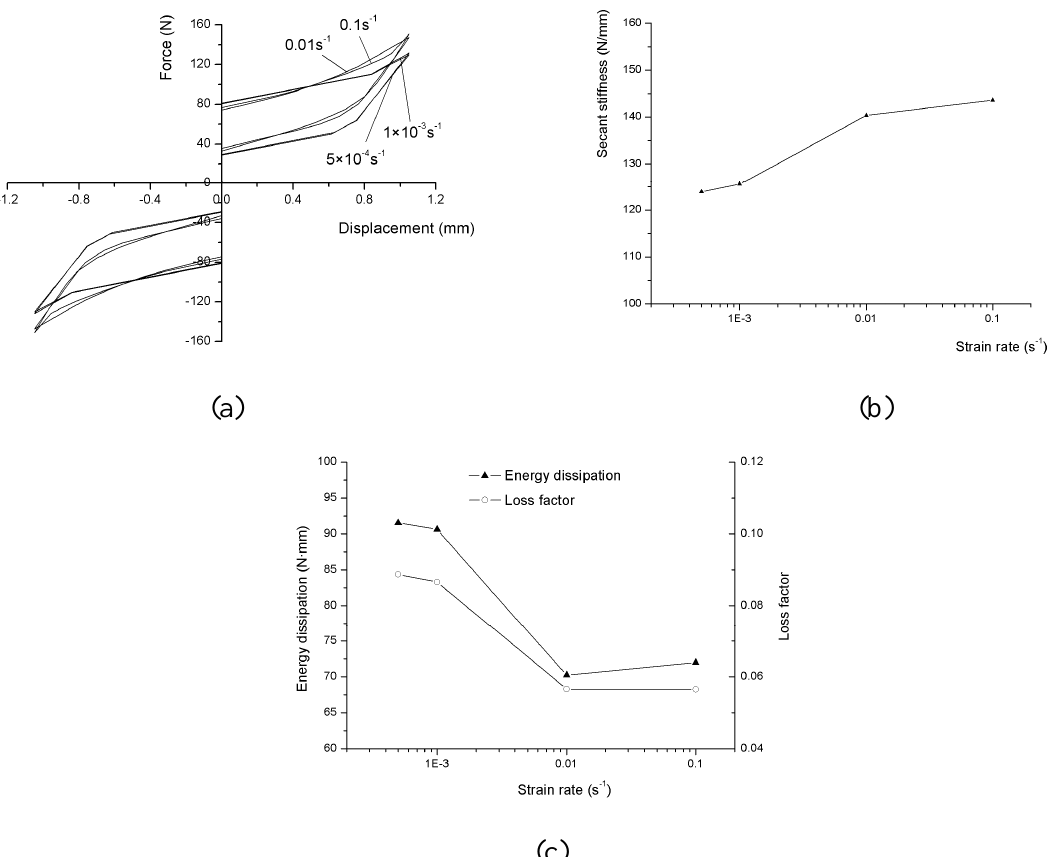
Figure 13 . Mechanical behavior of damper with strain rate variation: (a) Schematic diagram of the force-displacement curve; (b) Secant stiffness; (c) Dissipated energy and loss